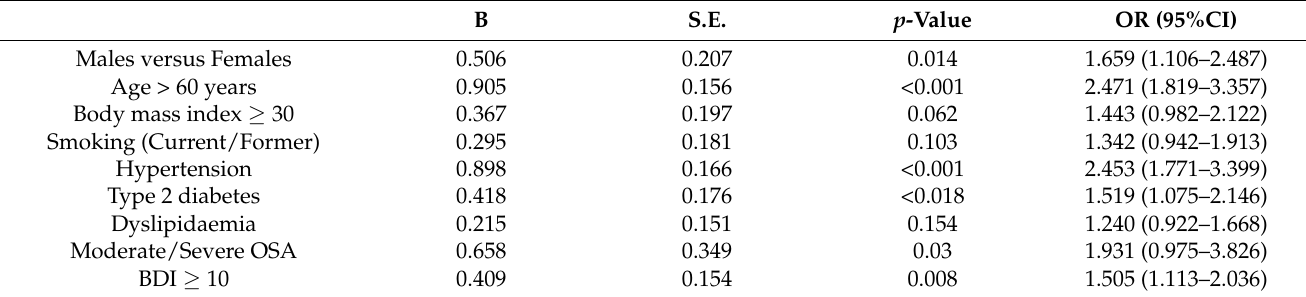
Table 4. Multiple stepwise logistic regression analysis of the relationship between CVD and various independent